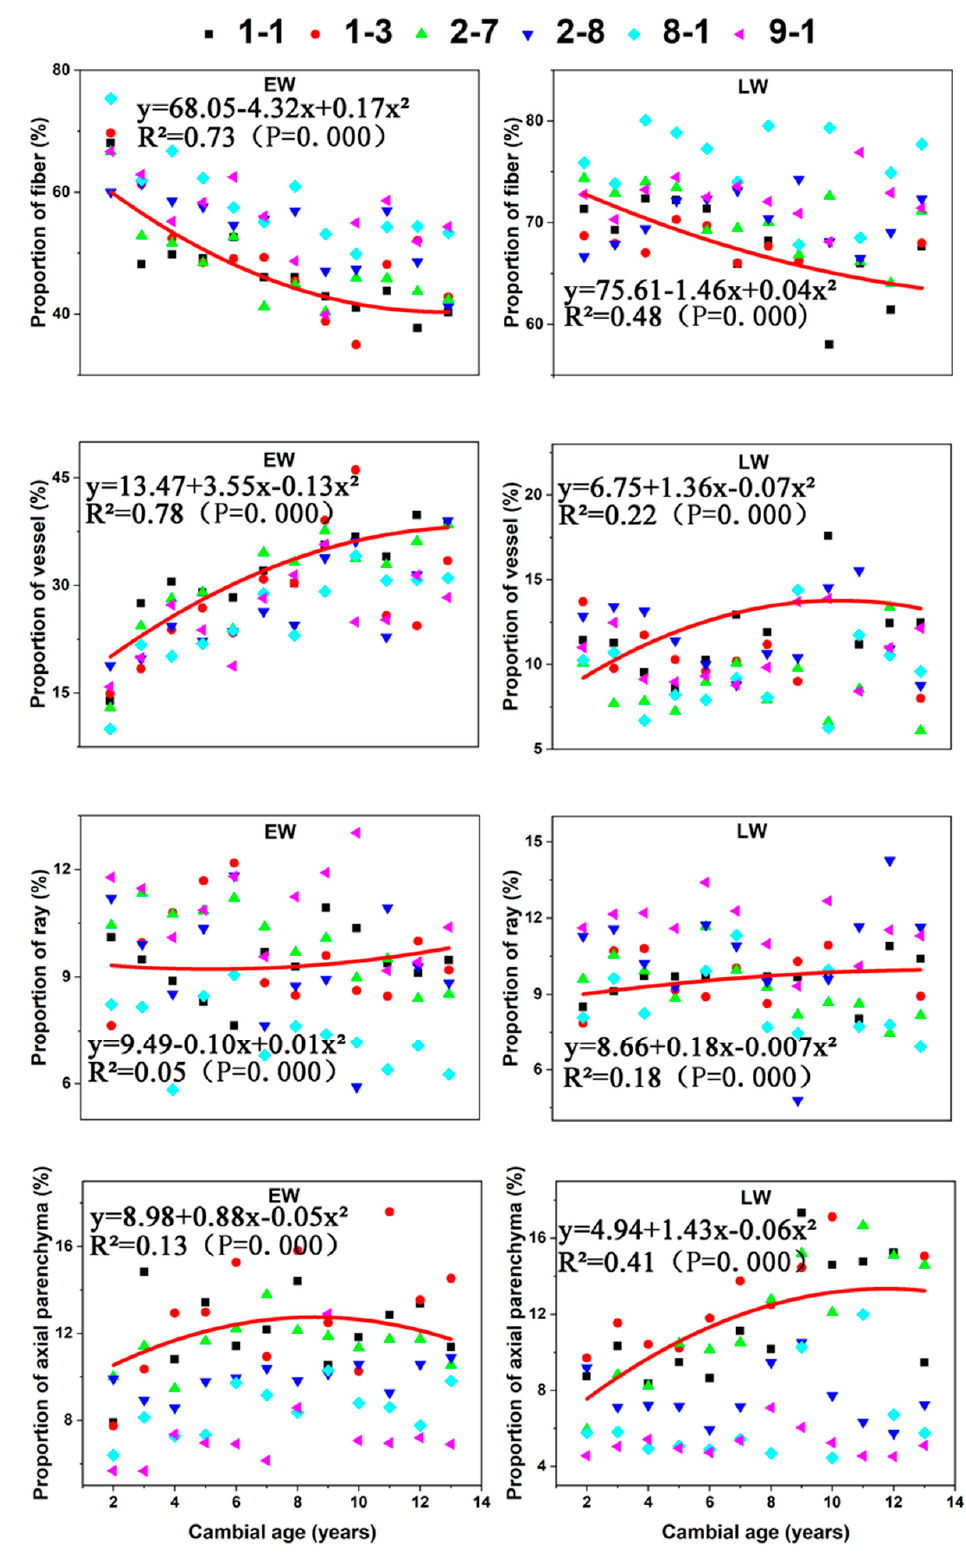
Figure 8. The proportion of di ff erent tissues in earlywood (EW) and latewood (LW): proportion of fiber, proportion of vessel, proportion of ray, and proportion of axial parenchyma for the six C . bungei clones versus cambial age.